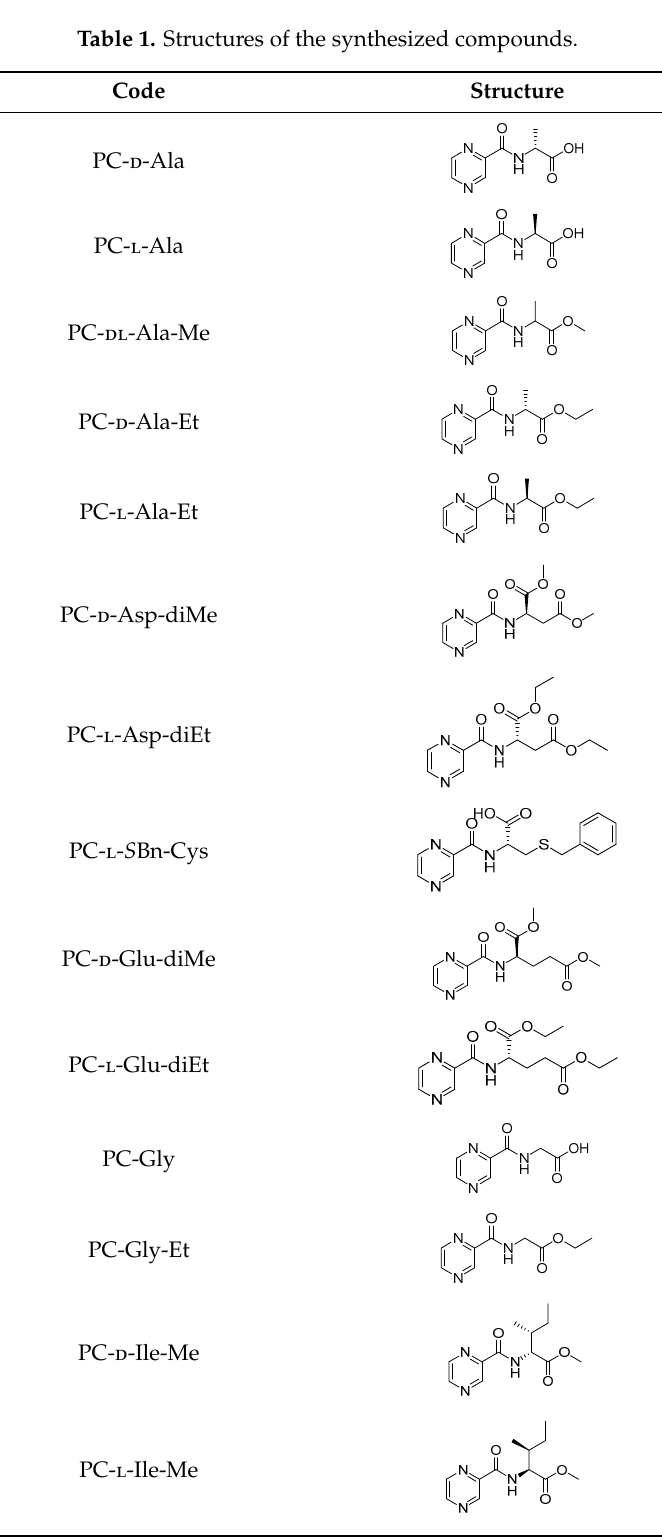
Table 1. Structures of the synthesized compounds.